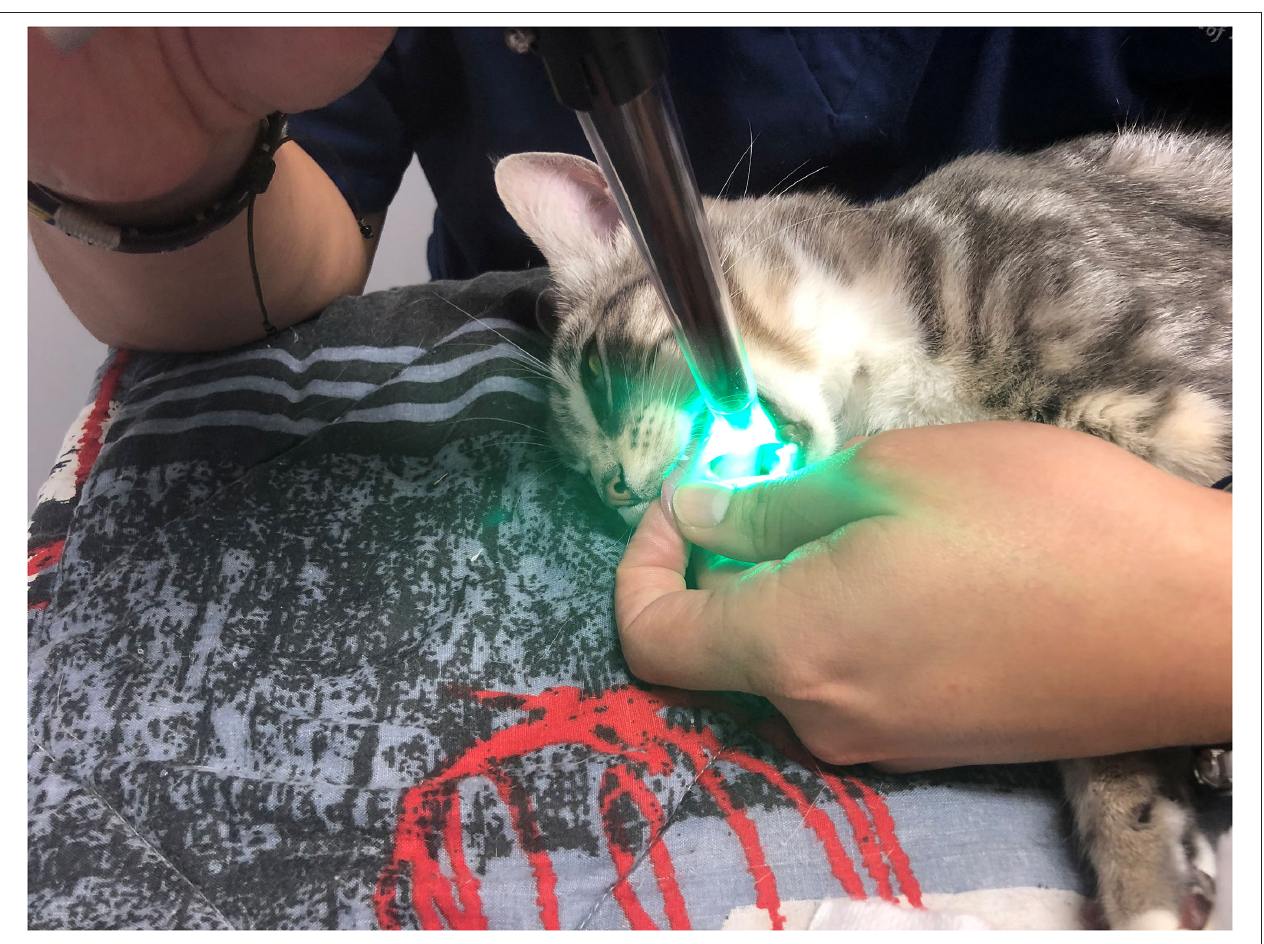
FIGURE 2 | Probe positioning of the sidestream dark field videomicroscopy camera for GlycoCheck ®